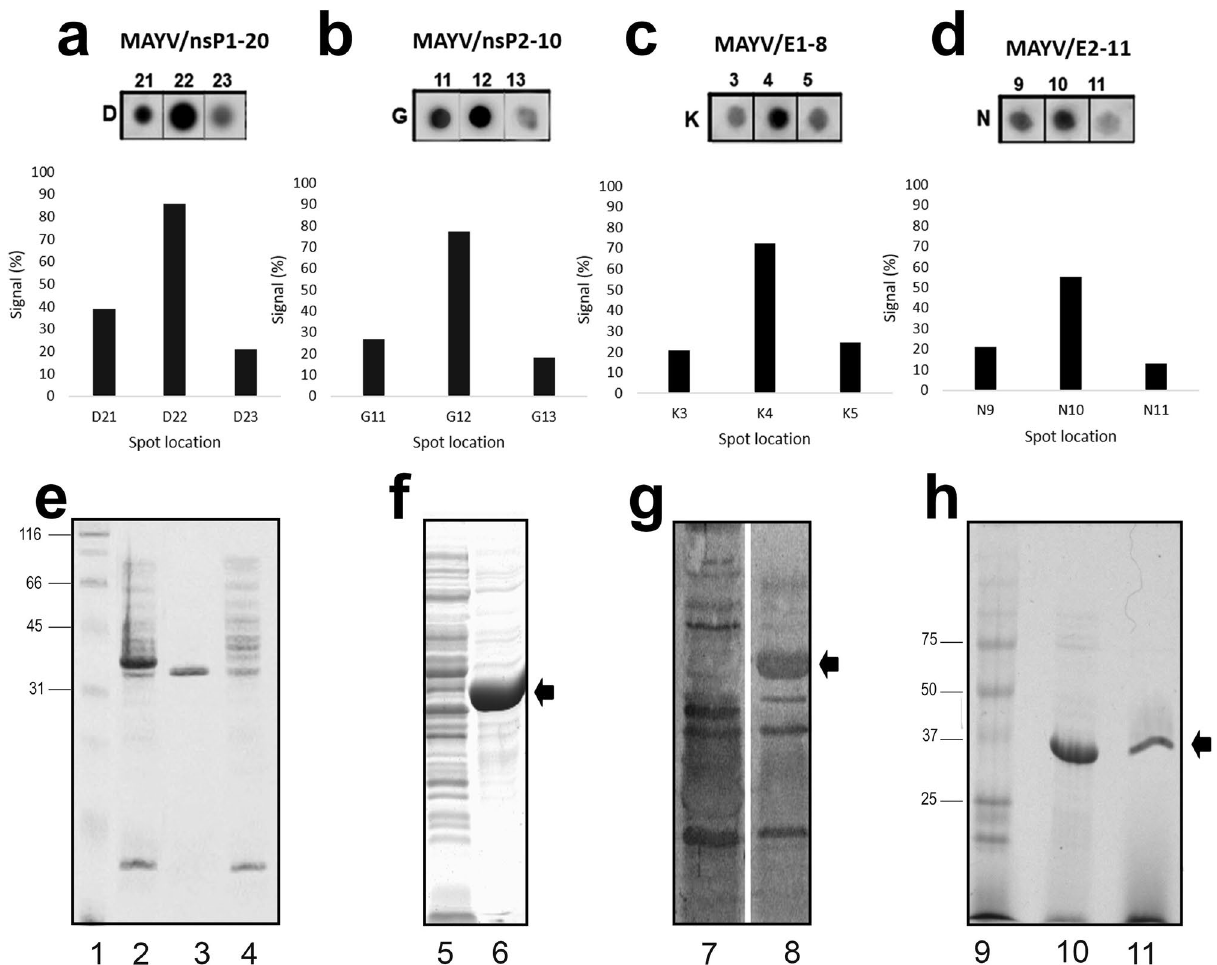
Figure 1. Epitope identification and production of Dx-MAYV-M. The entire IgM epitome of MAYV was revealed by Spot synthesis. The image of the reactivity from three consecutive peptides that define the minimal motif of the four epitopes that showed the lowest theoretical potential for cross-reactivity to other pathogens, along with a quantification of the relative intensity, is indicated for nsP1-20 ( a ); nsP2-10 ( b ); E1-8 ( c ); and E2-11 ( d ). Overexpression of the bioengineered Dx-MAYV-M protein in E. coli led to mostly insoluble protein that could be purified by IMAC. ( e ) SDS-PAGE with lane 1, molecular markers; lane 2, whole extract; lane 3, inclusion bodies; lane 4, soluble proteins. ( f ) An overloaded SDS-PAGE gel of soluble (lane 5) and insoluble (lane 6) protein. ( g ) A western blot of soluble (lane 7) and insoluble (lane 8) protein probed with Mayaro fever patient sera. ( h ) SDS-PAGE of Dx-MAYV-M before (lane 9) and after (lane 10 and 11) affinity purification by a HisTrap column (from insoluble fraction and soluble proteins, bands could be observed to be attributed to human sera’s general reactivity against bacterial proteins. The puri- fication of Dx-MAYV-M by immobilized metal affinity chromatography (IMAC) was feasible in the presence of urea, and soluble protein could be purified after removal of urea on-column before elution (Fig. 1h). ELISA‑peptide assay and performance comparison. To verify the epitopes’ expected individual diag- nostic performance, two synthetic bispecific multiple antigen peptides with eight copies (MAP8) were chosen and used in an in-house peptide ELISA. The particular serum in the pool of the five from infected patients used in the peptide library screen along with an additional thirteen was tested for sensitivity, and a variety of sera from patients infected with CHIKV, YFV (vaccinated), DENV, ZIKV, hepatitis B (HBV), leptospirosis (LEP), leishma- niasis (LEISH), and Chagas disease (CD) patients along with fifty, non-symptomatic healthy donors were tested for cross-reactivity. Excellent performance for MAYV/nsP1-20 and MAYV/E2-11 with all MAYV patient serum and signals above the cut-off was measured (Fig. 2a). Besides, no cross-reactivity was observed, and the results were statistically significant (p < 0.001). Performance of Dx‑MAYV‑M in Mayaro fever’s serodiagnosis. To determine whether the multi- epitope chimeric protein could be considered an effective tool for the serodiagnosis of acute MAYV infections, we analyzed its reactivity against the same panel of sera as used to screen the peptide library (Fig. 2a). The posi-